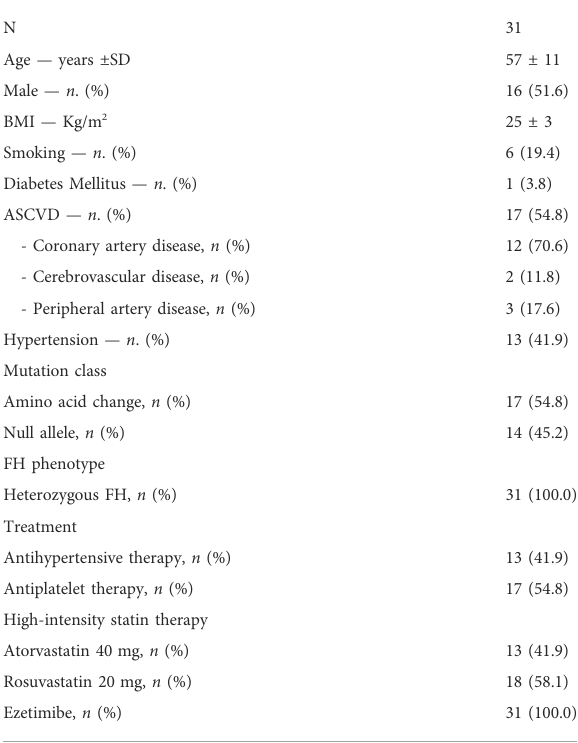
TABLE 1 Characteristics of the study